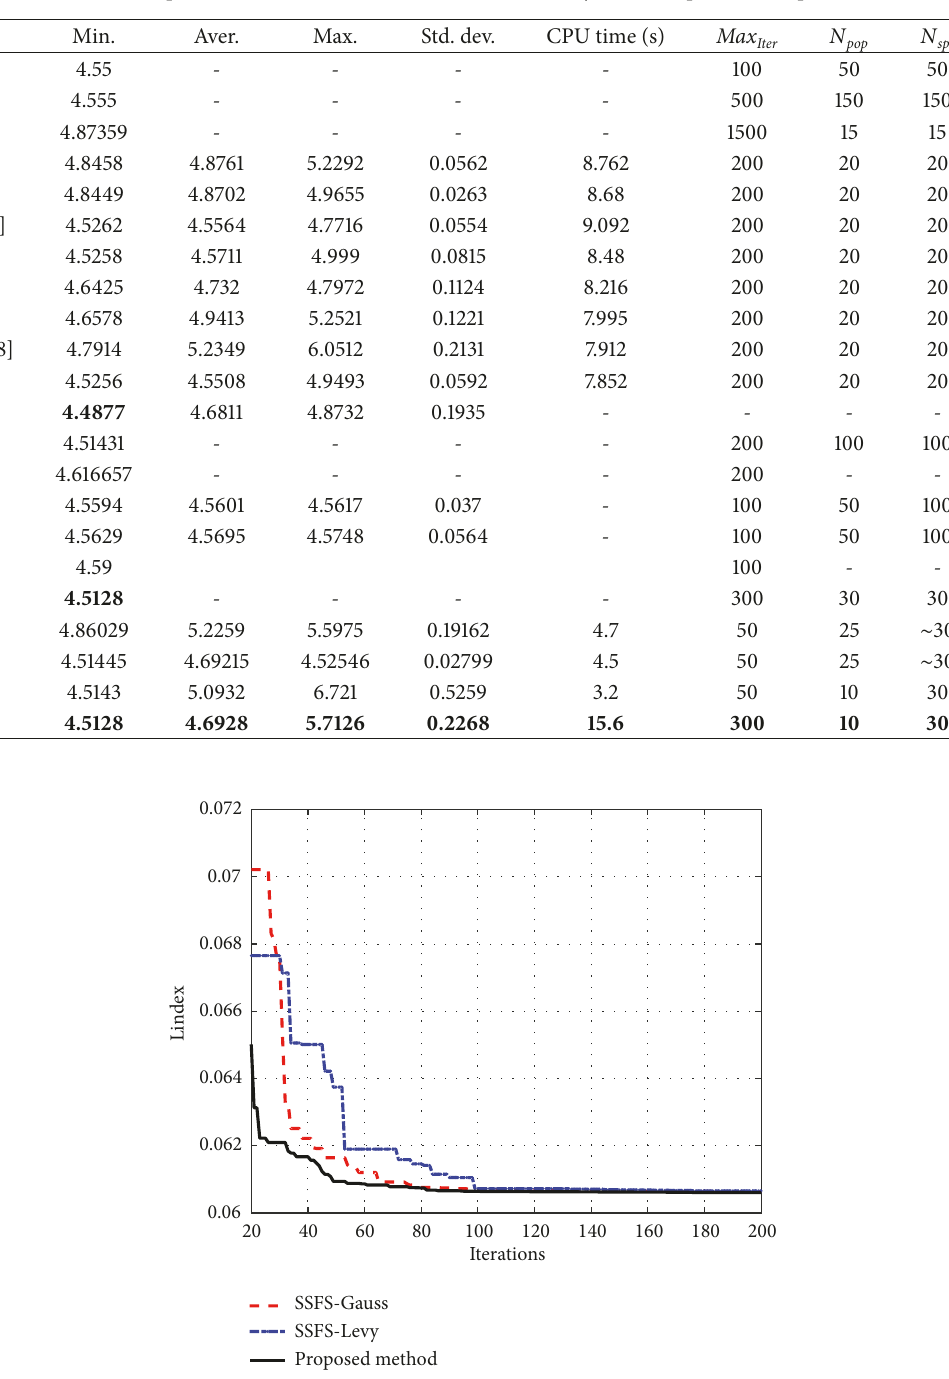
Figure 15: The best run obtained by three methods for L-index optimization of IEEE 118-bus